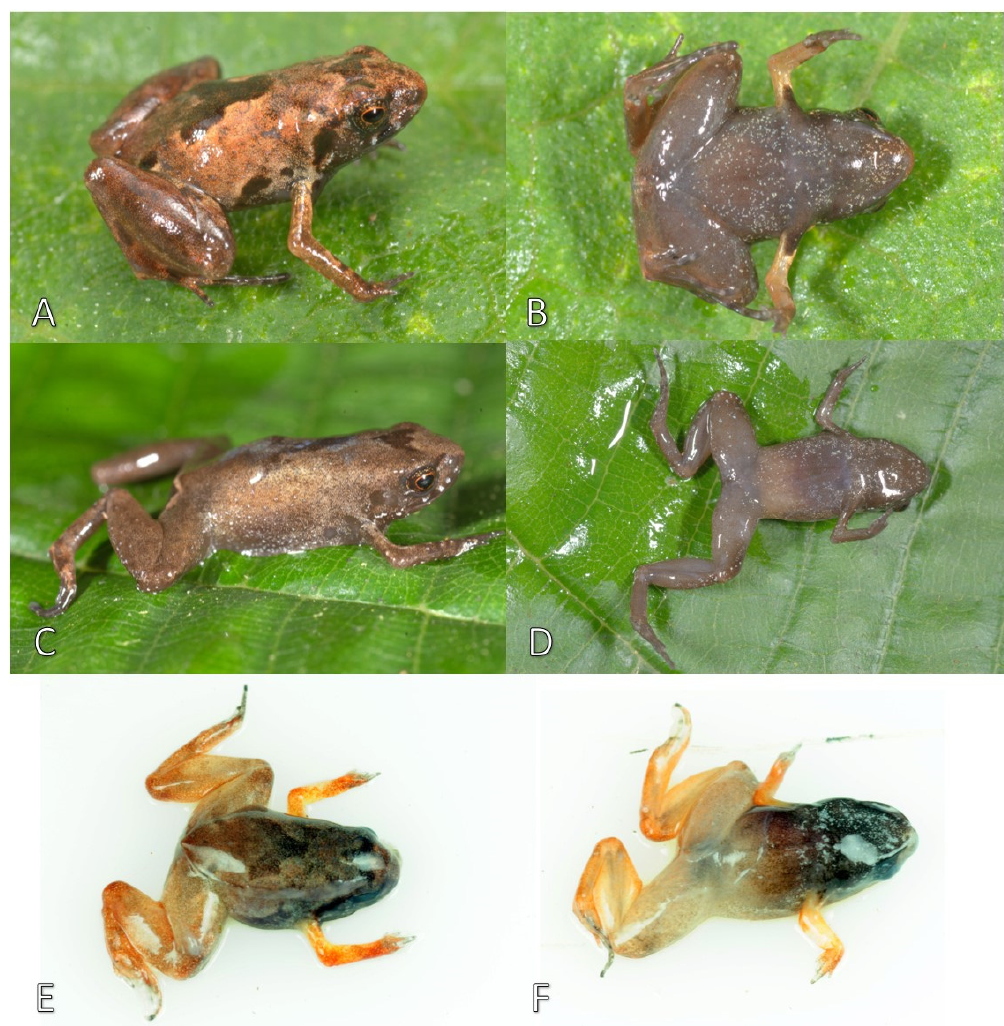
Figure 10. Photographs of live specimens of Noblella losamigos sp. n. ( A ) Dorsal view and ( B ) ventral view of CORBIDI 17524, adult male paratype (SVL 9.8 mm); ( C ) dorsal view and ( D ) ventral view of MUSM 30426, adult female paratype (SVL 13.1 mm); ( E ) dorsal view and ( F ) ventral view of MUBI 17412, juvenile paratype (SVL 7.1 mm).